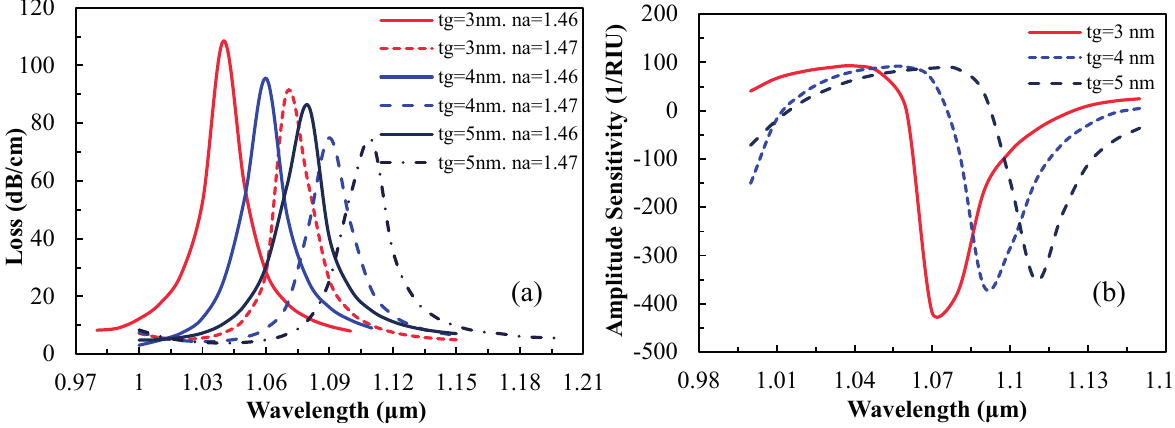
Figure 6. ( a ) Loss spectrum and ( b ) amplitude sensitivity as a function of wavelength by varying graphene layer thickness (analyte n a = 1.46 and silver layer thickness t ag = 40